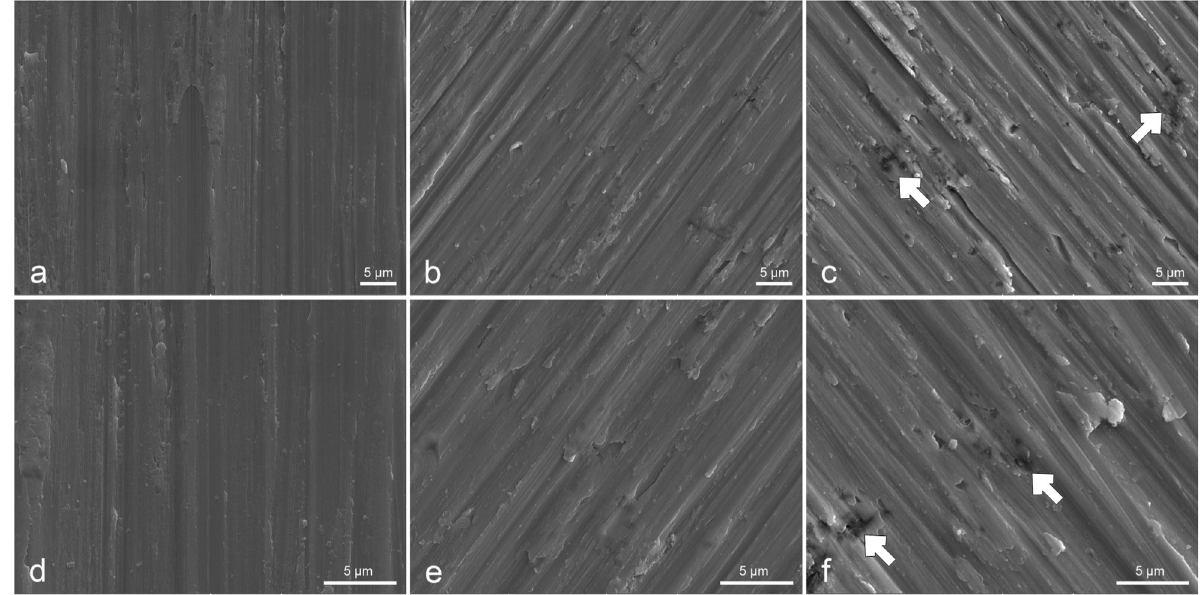
Fig. 1 SEM images of titanium samples under different concentrations of uric acid exposure for 7 days. Upper panel (( a )Ti-UA-0; ( b )Ti-UA-5; ( c ) Ti-UA-15) images at 5000 × magni fi cation. Lower panel (( d ) Ti-UA-0; ( e ) Ti-UA-5; ( f ) Ti-UA-15) images at 10,000 × magni fi cation